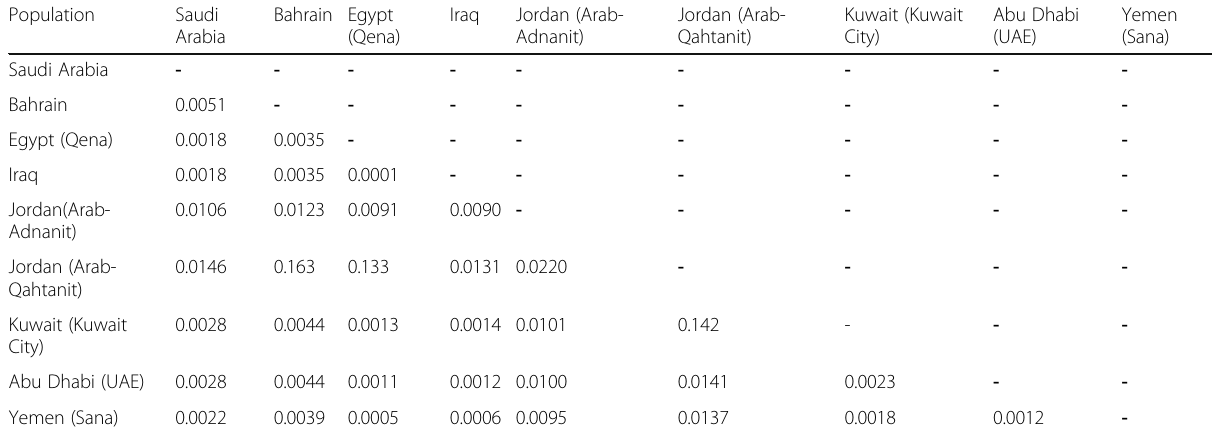
Table 4 Matrix of the pairwise F ST genetic distances between native Saudi population and eight neighboring Arab populations (below diagonal) obtained for 10,100 permutations (s.e. ≤ 0.0038)